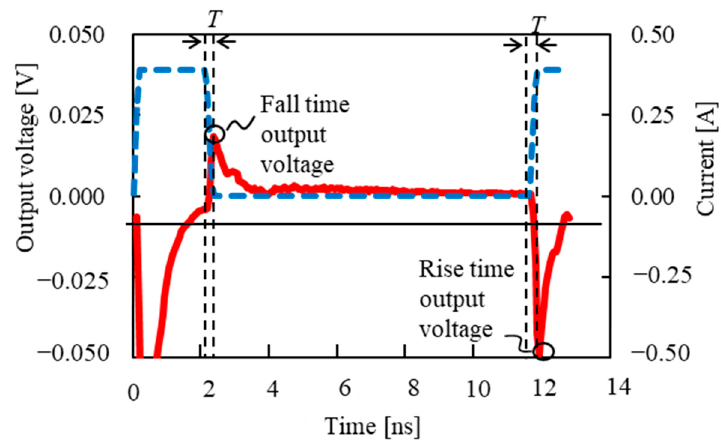
Figure 5. Pulse current waveform and an example output voltage.